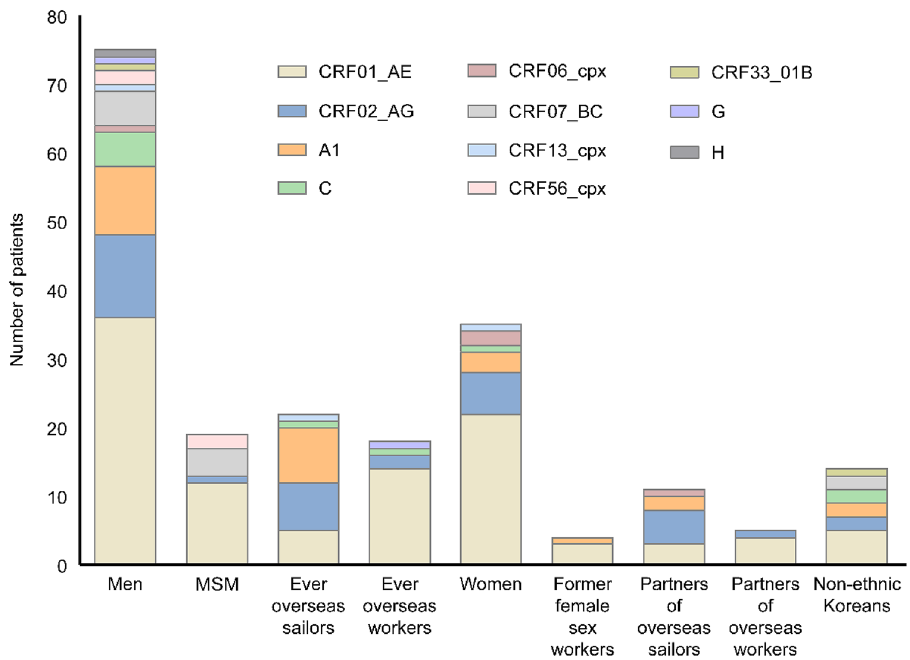
Figure 4. Changes in the distribution of non-B HIV-1 subtypes among 110 patients with HIV infection, stratified by the risk groups for HIV